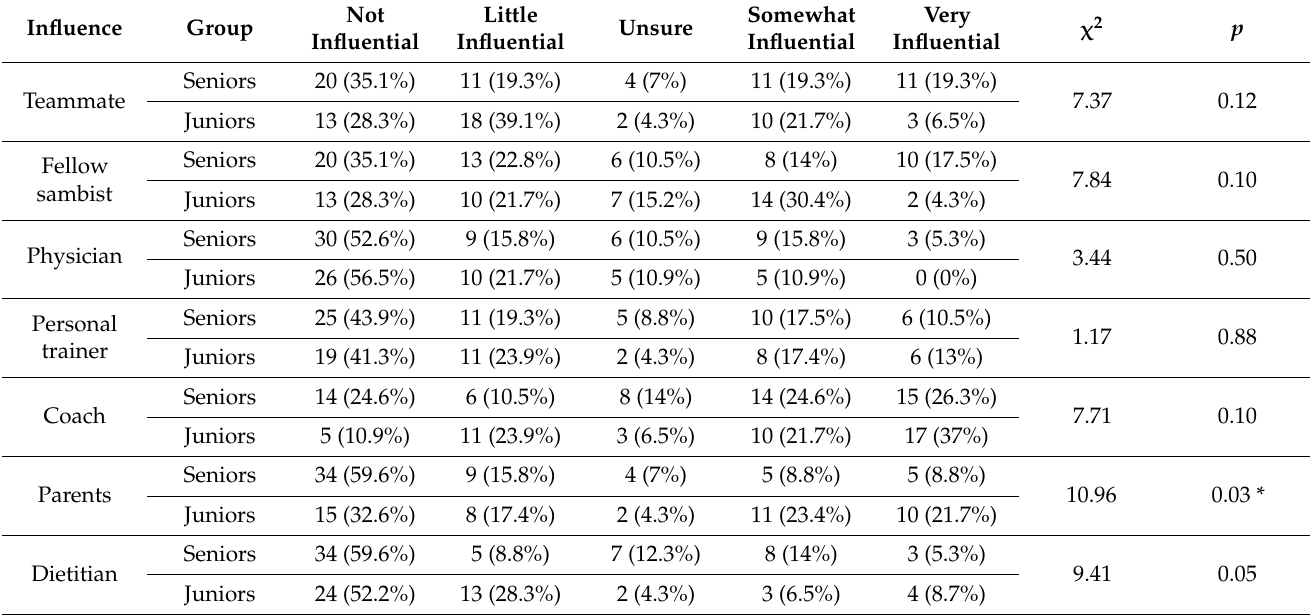
Table 4. Frequency distribution for people influencing rapid weight loss